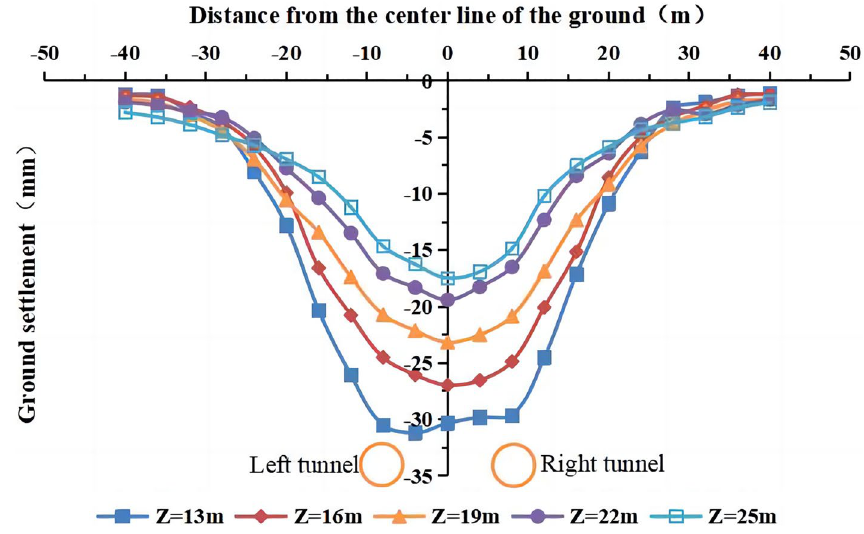
Figure 26. Surface settlement during double-line excavation for different buried depths.